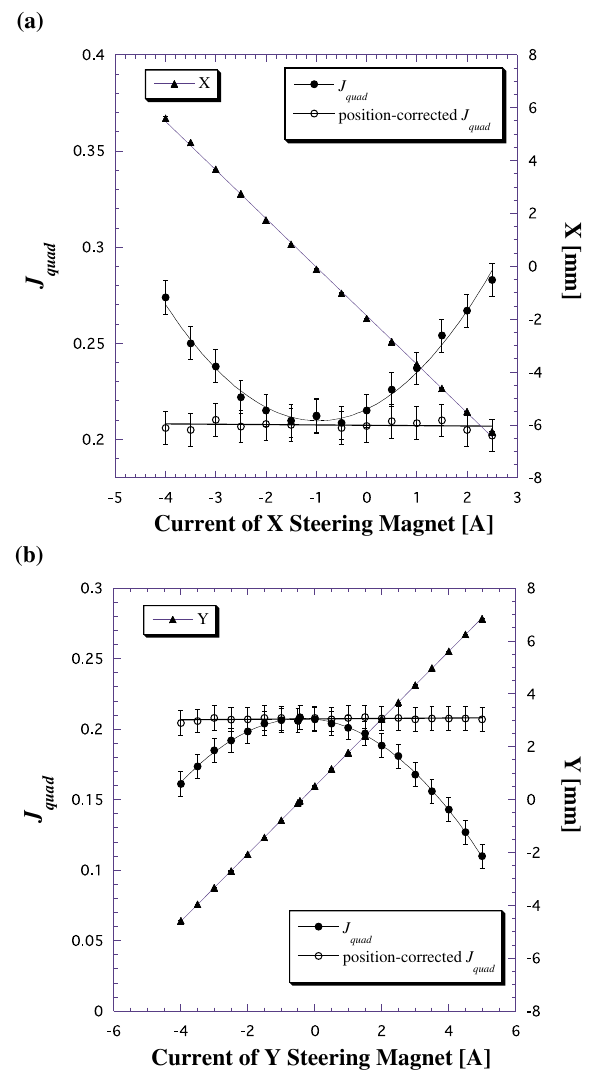
FIG. 5. (Color) Variations of the quadrupole moment depend- ing on the field strength of (a) the horizontal and (b) the vertical upstream steering magnets for the 0.9-nC electron beam with and without beam-position corrections, respectively. The straight lines show that the beam positions are very linear with the field strength of the steering